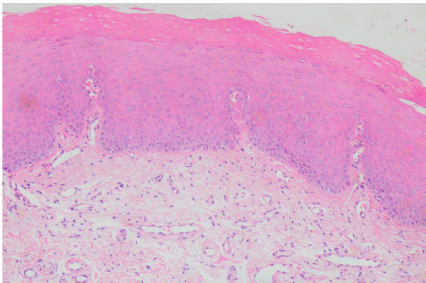
Figure 2: Benign hyperkeratosis with no dysplasia. Histopathologic examination shows hyperortho- and parakeratosis of stratified squamous epithelium. Mild architecture changes with acanthosis and no cellular atypia. (H and E stain, Magnification x100). H and E; hematoxylin and